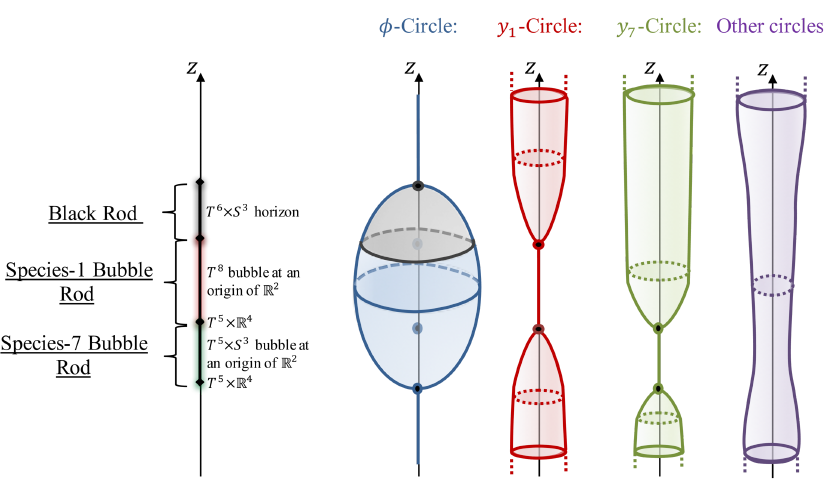
Figure 3 . Schematic description of connected rods by making the rods of figure 2 touch. The φ -circle does not shrink along the rod configuration, and the solution is